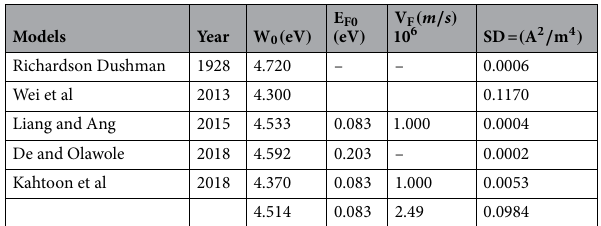
Table 1. Influence of work function, Fermi energy, and Fermi velocity on the current density of graphene as dictated by the square difference (SD).